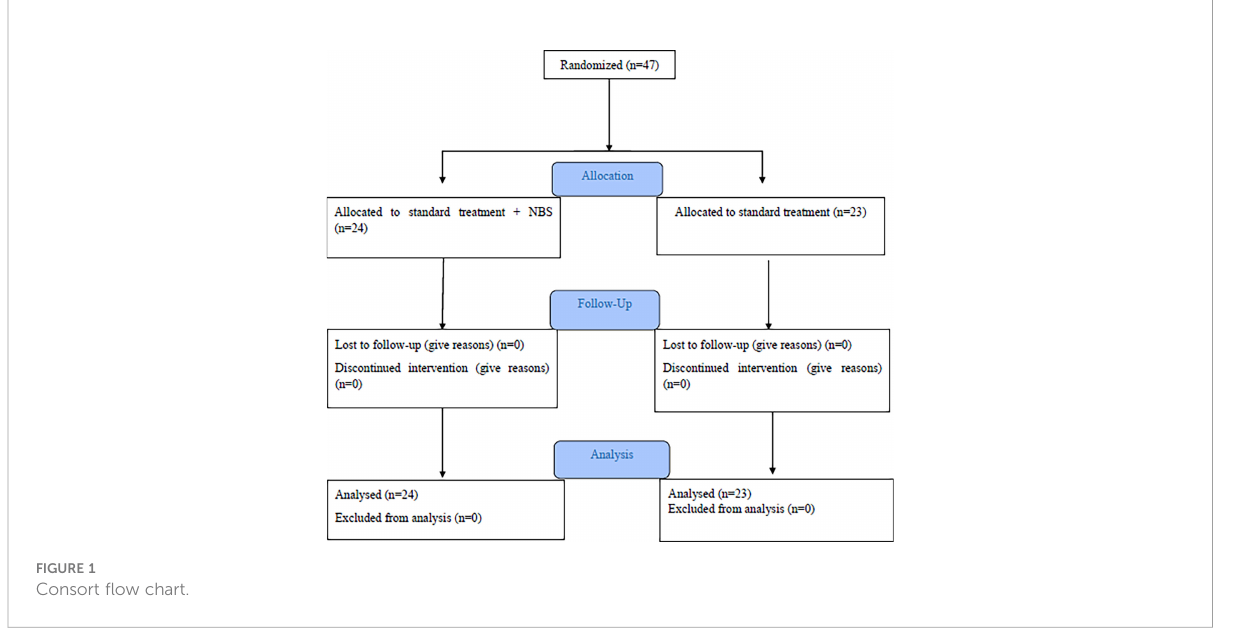
FIGURE 1 Consort fl ow chart.